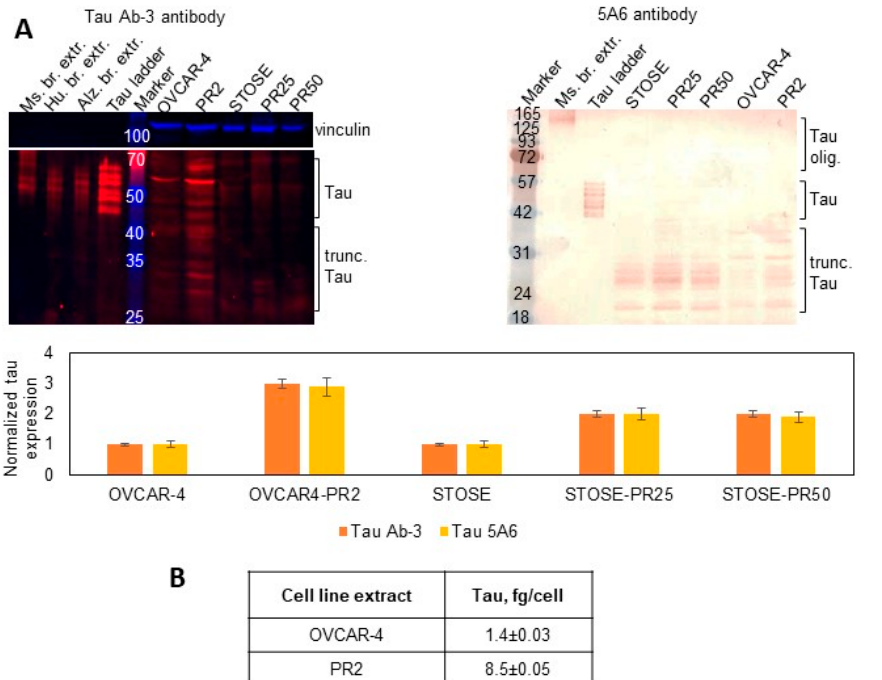
Figure 1. Expression of tau in parental cell lines and paclitaxel-resistant clones. ( A ) Expression of tau was examined with Western blot using tau Ab-3 antibodies (1:100 dilution) and 5A6 antibodies (1:50 dilution) in the parental and paclitaxel-resistant cells and measured with digital densitometry. Vinculin (1:1000 dilution) was used as a loading control. Mouse and human brain extracts and tau ladder consisting of 6 tau isoforms were used as positive controls. The uncropped blots are shown in File S1. ( B ) Total tau was measured by ELISA in cell extracts and derived as fg/cell.